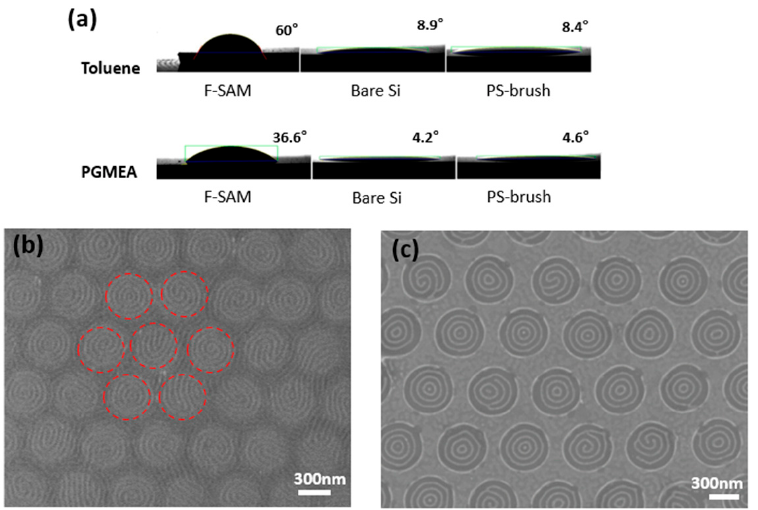
Figure 3. ( a ) Measured contact angles of toluene and PGMEA on various coated Si substrates. ( b ) SEM images of a dewetted BCP film on the guiding template after spin coating with BCP/PGMEA. Red circles indicate the PS brush-coated areas of the substrate. ( c ) SEM images of a dewetted BCP film on the guiding template after spin coating with BCP/toluene.